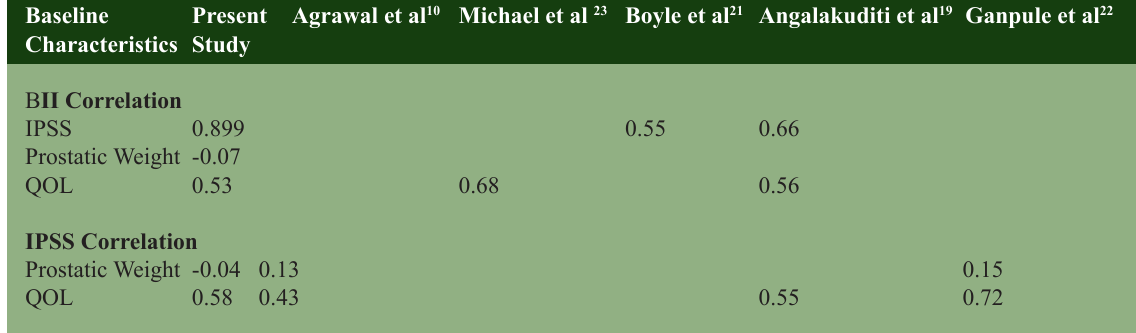
Table 4. Comparison of studies that assessed the Correlation of BII, IPSS, QOL and Prostatic